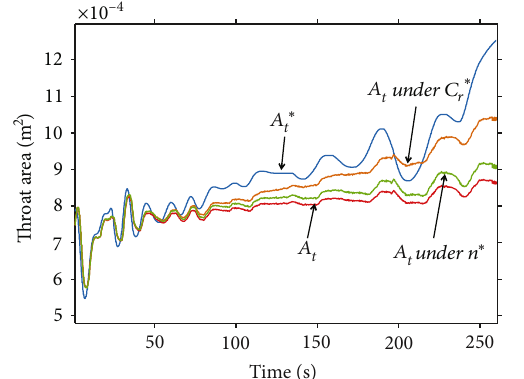
Figure 25: In fl uence of propellant parameter perturbation on throat identi fi